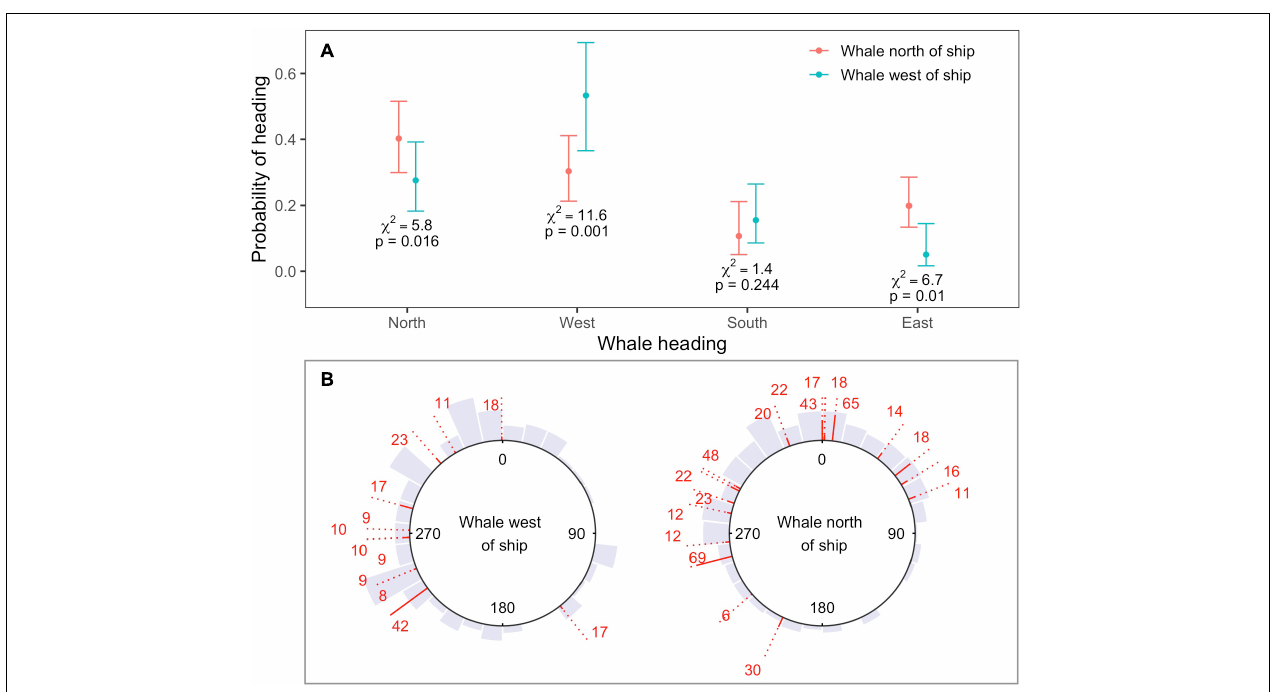
FIGURE 4 | (A) Estimated probability of heading north, west, south, or east as a function of whale bearing relative to ship, as obtained from four independent binomial GEEs (one model for each cardinal direction). Responses were consistent with movement away from sonar-producing ships. Whales were more likely to head north if whale bearing was to the north or east of the ship, and more likely to move west when whale bearing was to the west; (B) observed headings shown by gray histograms, for whales located to the west (left-hand plot) or north (right-hand plot) of the closest MFAS ship. Headings between start and end locations are shown for each track as red lines. The solid part of each line standardizes the length of the dotted line by track length. Sample sizes (number of 5-min intervals) are shown at each line end. Headings show substantial individual variability, but little or no north-easterly movement when whale bearing was to the